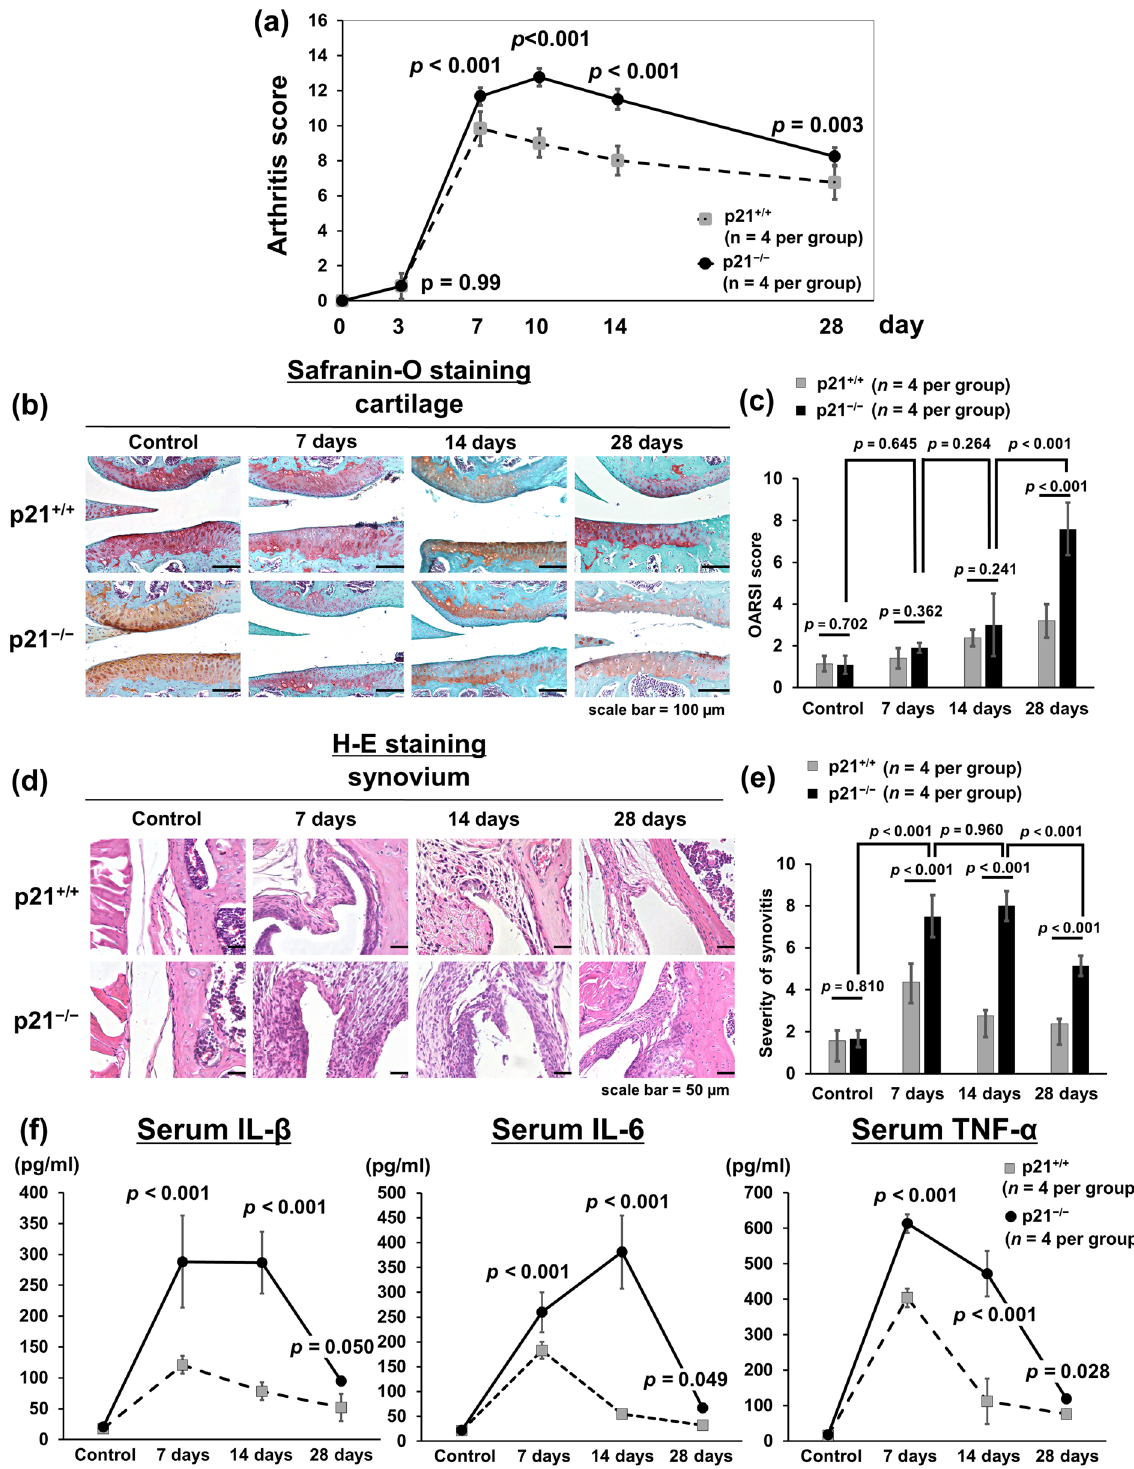
Figure 1. p21-deficient mice exhibit destructed knee joint, increased inflammatory arthritis, and enhanced systemic inflammatory cytokine expression in vivo. ( a ) OARSI-based arthritis scores of p21 −/− and p21 +/+ mice on days 7, 10, 14, and 28 after administration of the antibody cocktail. Cartilage and synovial tissue samples were collected from the knee and stained with ( b ) Safranin-O and Fast Green, and ( d ) hematoxylin and eosin, respectively. ( b,d ) p21 +/+ mice and p21 −/− mice as controls and on days 7, 14, and 28. ( c ) Average sum of the OARSI cartilage OA-histopathology scores and ( e ) average severity of synovitis scores with 95% CI from four quadrants (i.e., medial femoral condyle, medial tibial plateau, lateral femoral condyle, and lateral tibial plateau) and eight sections per knee. Four mice were analyzed from each group. ( f ) Serum levels of IL-1β, IL-6 and TNF-α of p21 −/− and p21 +/+ mice at each time point and control. In ( c,e,f ), four mice were analyzed from each group. Two-way analysis of variance and Tukey’s post hoc test for multiple comparisons of paired samples were used. CI confidence interval, CAIA collagen antibody-induced arthritis, p21 cyclin- dependent kinase inhibitor